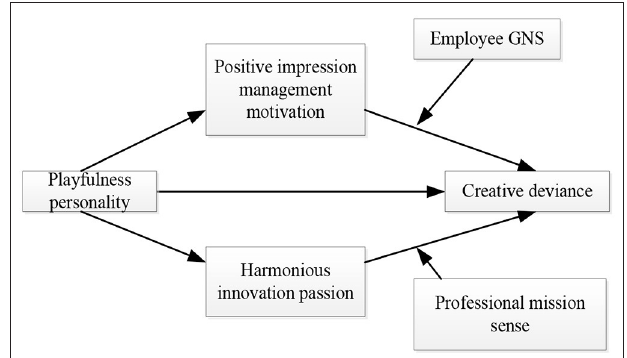
FIGURE 1 | Conceptual